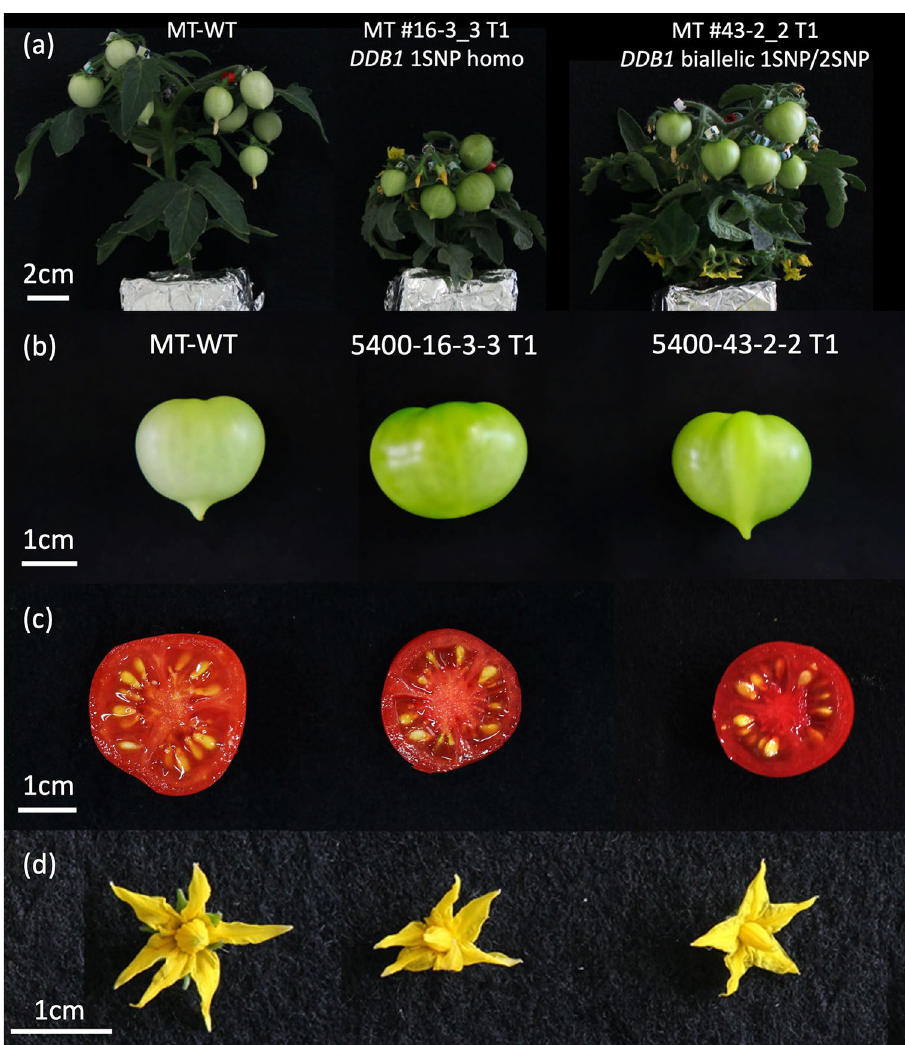
Figure 3. Plant phenotype of segregant generation. ( a ) Six-week-old plants in the T 1 generation. ( b ) Fruit size and color at the green mature stage (28 days post-anthesis). ( c ) Fruit color at the red ripe stage (12 days post- breaker stage). ( d ) Flower shape and color at the anthesis stage. We noted a similar degree of darkness between the red fruits of the WT and both mutant